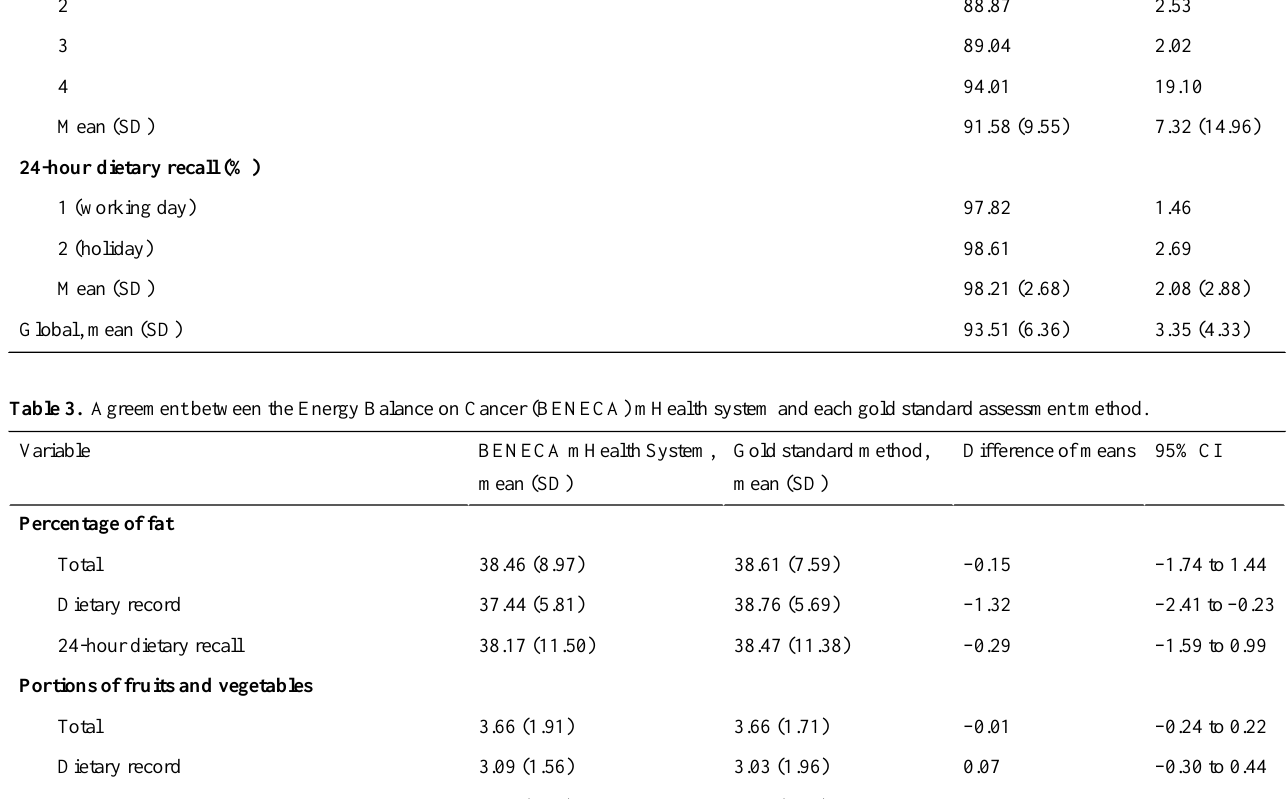
Table 2. Food item agreement between the Energy Balance on Cancer (BENECA) app and the gold standard dietary instruments.